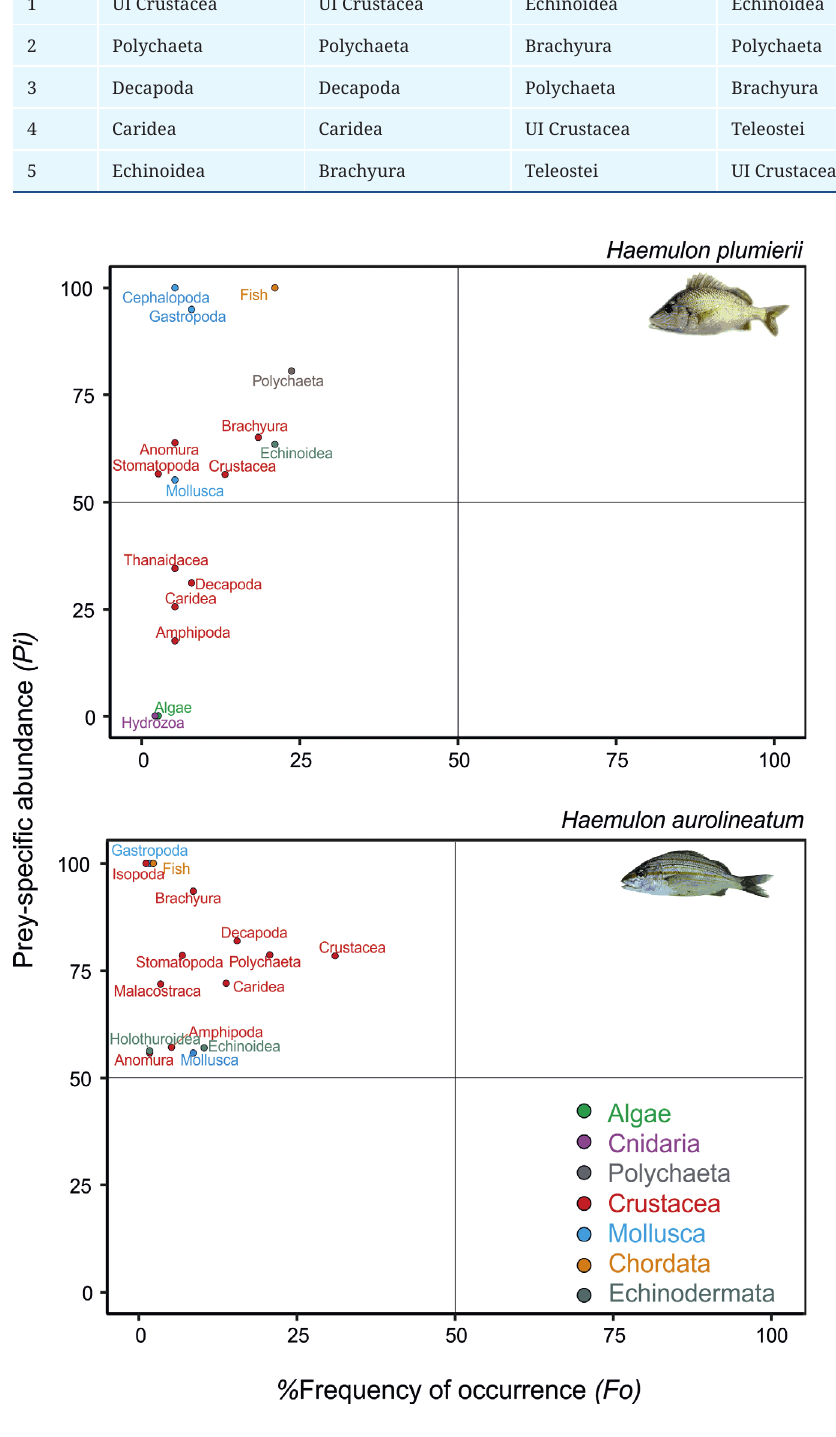
FIGURE 3 | Modified Costello diagram (Pi, prey specific abundance; Fo, frequency of occurence), a scatterplot containing all prey items, showing the feeding strategy of Haemulon aurolineatum and H. plumierii captured along the northeast coast of Brazil.